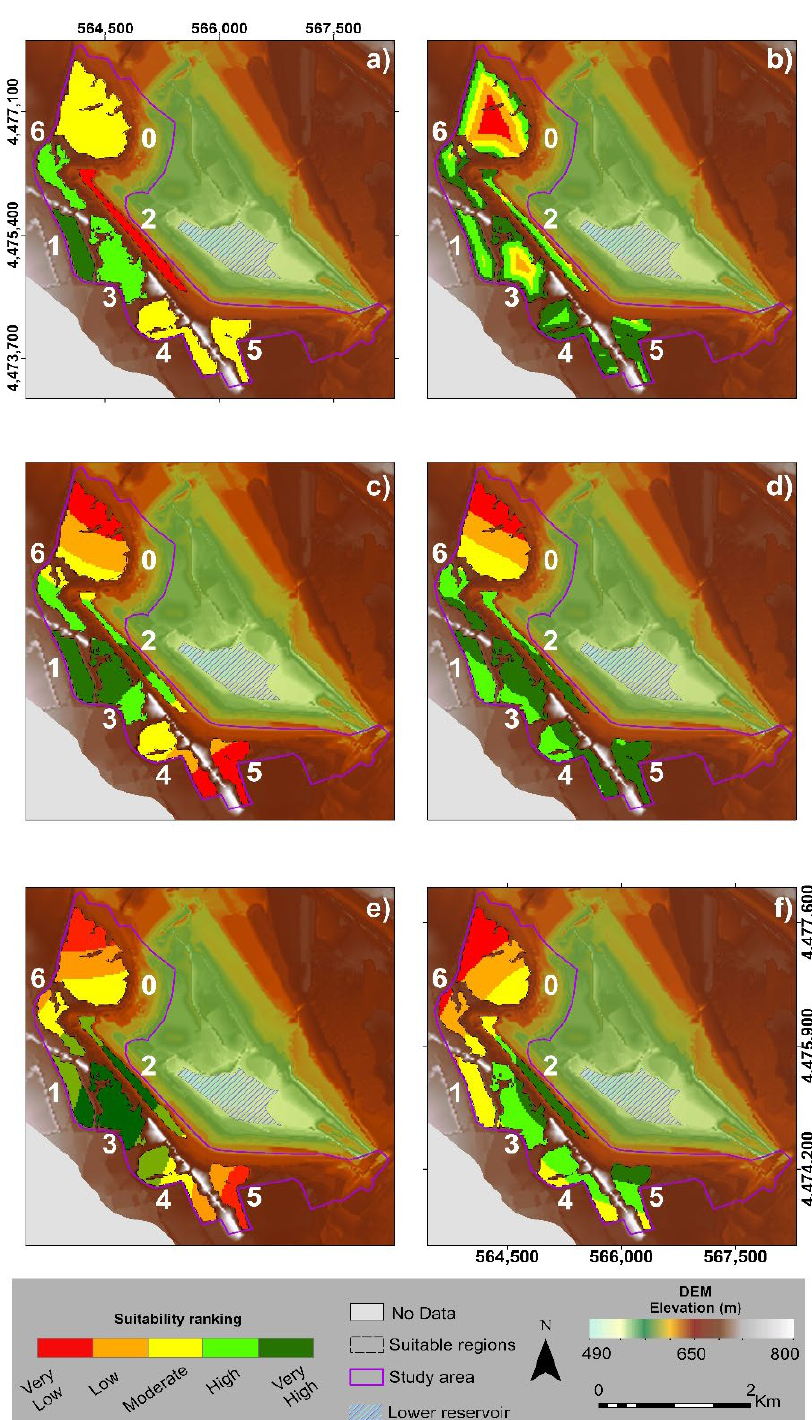
Figure 10. Criteria ranking maps illustrating the suitability score from very low (red color) to very high (dark green colors) regarding the HPHS proposed sites according to the ( a ) average head elevation difference, ( b ) distance from transportation network, ( c ) distance from geological faults, ( d ) distance from power transmission grid, ( e ) distance from drainage network and ( f ) distance from lower reservoir.